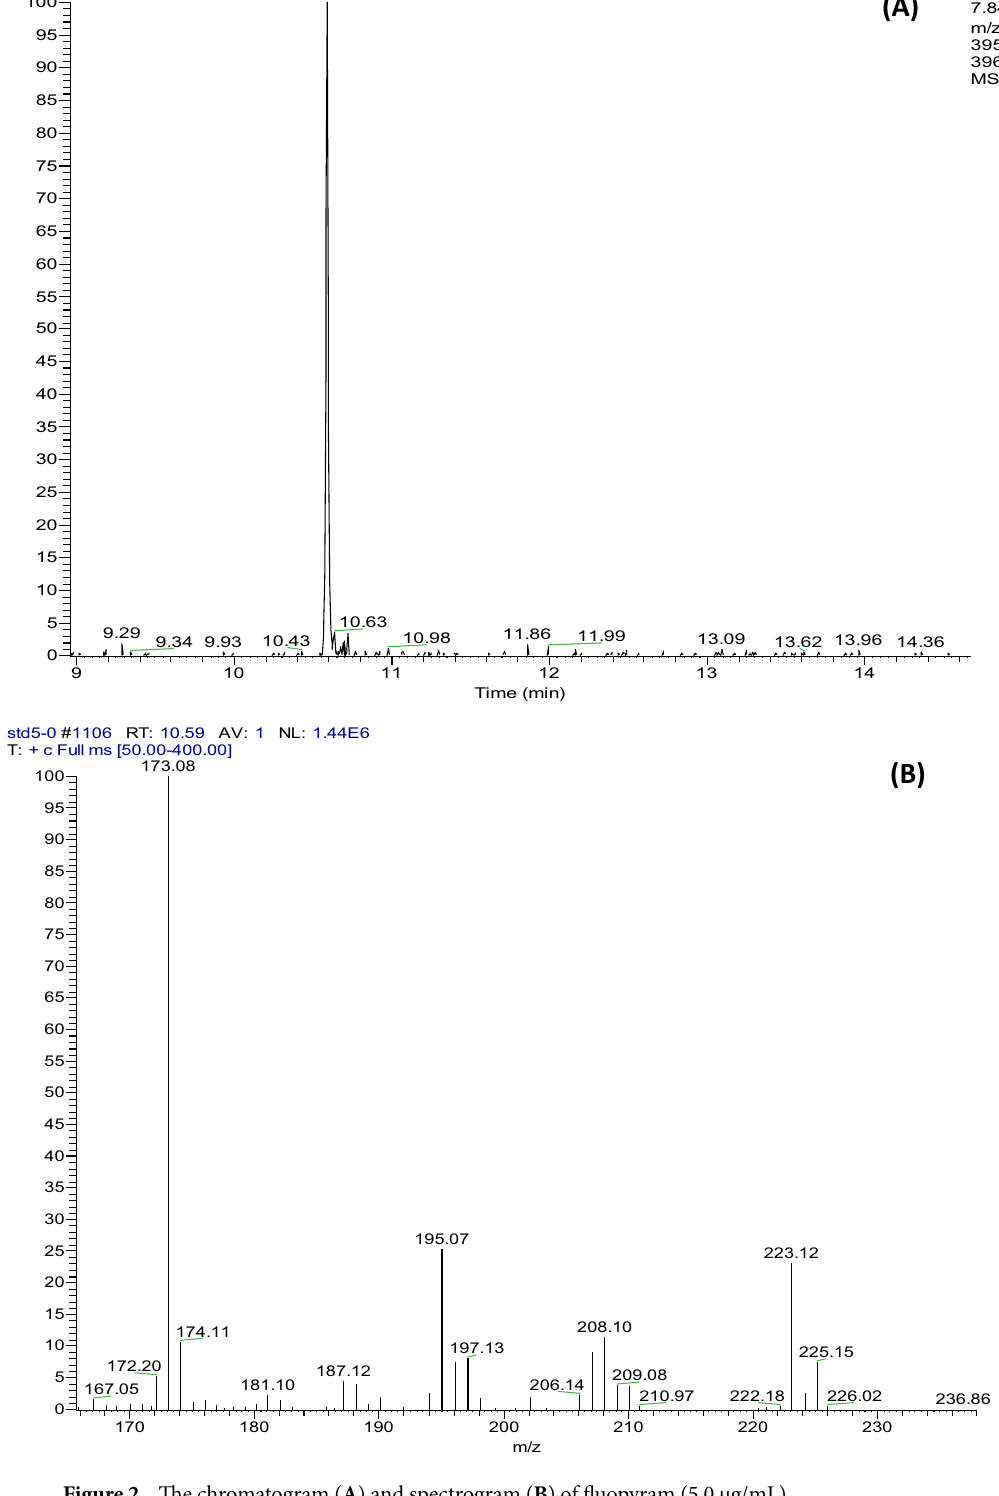
Figure 2. The chromatogram ( A ) and spectrogram ( B ) of fluopyram (5.0